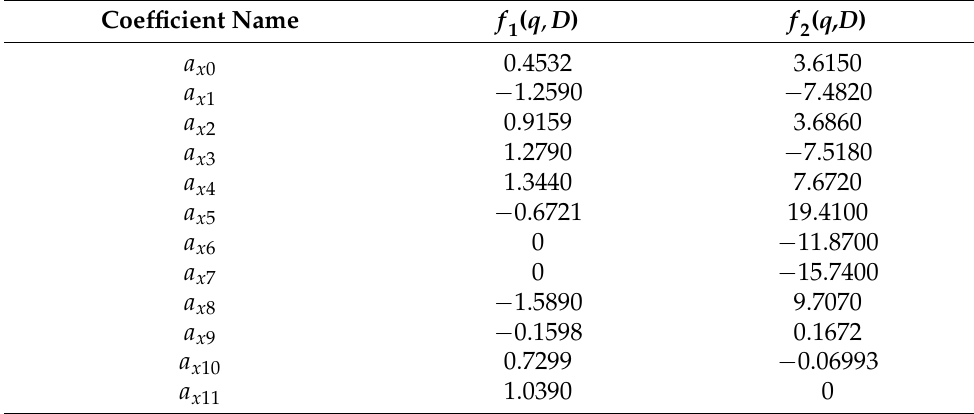
Figure 6. h f graphs. ( a ) 3D plot. ( b ) Fitting residuals. Table 1. Coefficients of h f